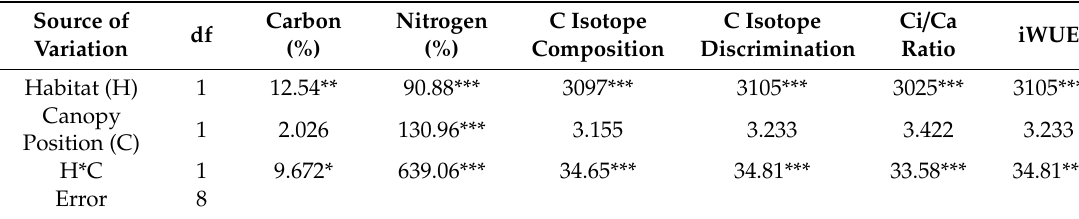
Table 2. Results of two-way ANOVA (F-values) testing the e ff ects of habitat type (saline vs. non-saline) and canopy position (east and west) on carbon (%), nitrogen (%), carbon isotope discrimination,